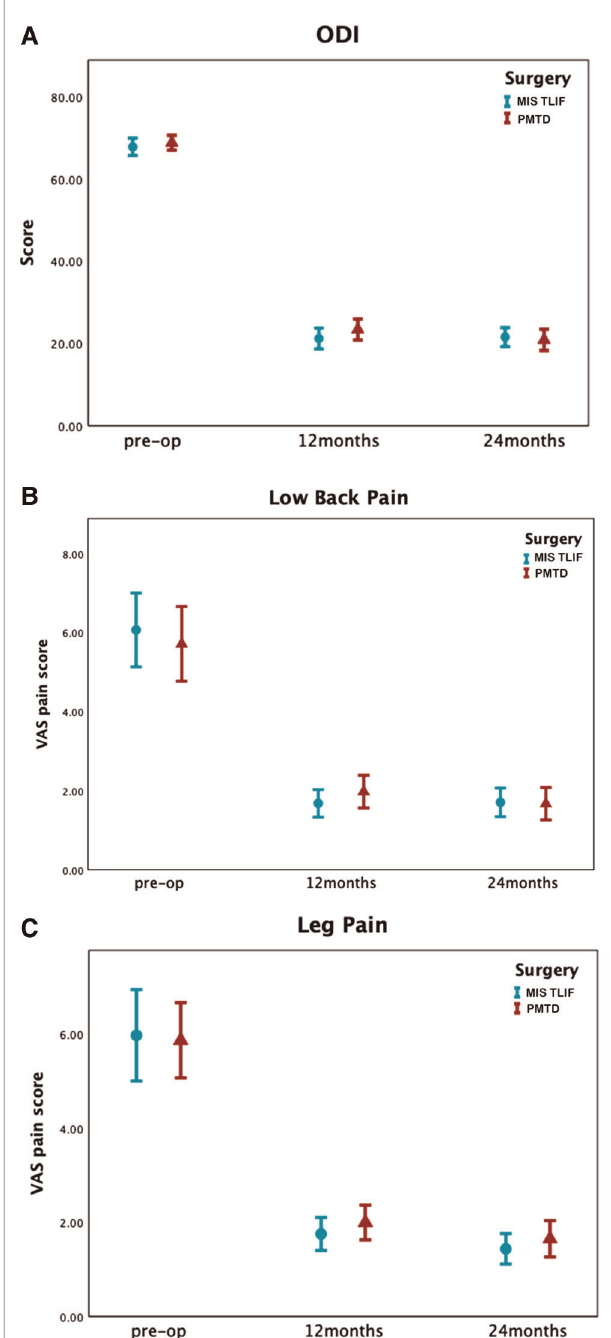
FIGURE 3 | Preoperation, 12-month, and 24-month ODI and VAS following surgery for DLS-I-LSS. ( A ) Average ODI at preoperation, 12 months, and 24 months following surgery, by cohort. ( B ) Average VAS low back pain scores at preoperation, 12 months, and 24 months following surgery, by cohort. ( C ) Average VAS leg pain scores at preoperation, 12 months, and 24 months following surgery, by cohort. For both cohorts there were statistically signi fi cant improvements at 12 and 24-month follow-up, relative to preoperation, for ODI, VAS low back pain and VAS leg pain ( p <0.001, all comparisons).